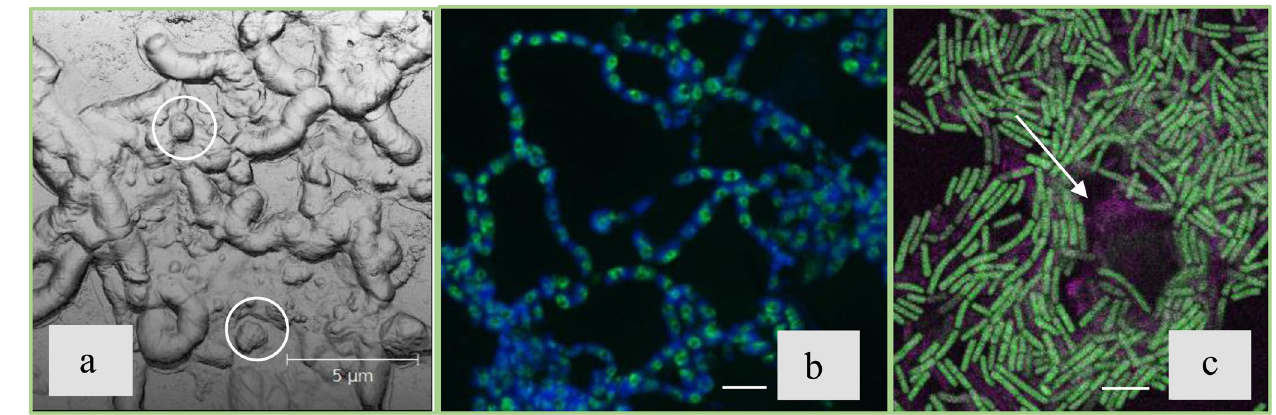
Fig. 4 B. cereus 4B at the third stage of the growth (24 – 33 h after inoculation). a AFM image of the sample taken at 33 h after inoculation. b Confocal microscopy image with Sytox green (eDNA, green color) and Bromophenol blue (amyloid structures, blue color) staining. c Confocal microscopy image staining with Thio fl avin T (amyloid structures, green color) and Congo red (amyloid structures and/or polysaccharides, pink color); All scale bars correspond to 5 µm.